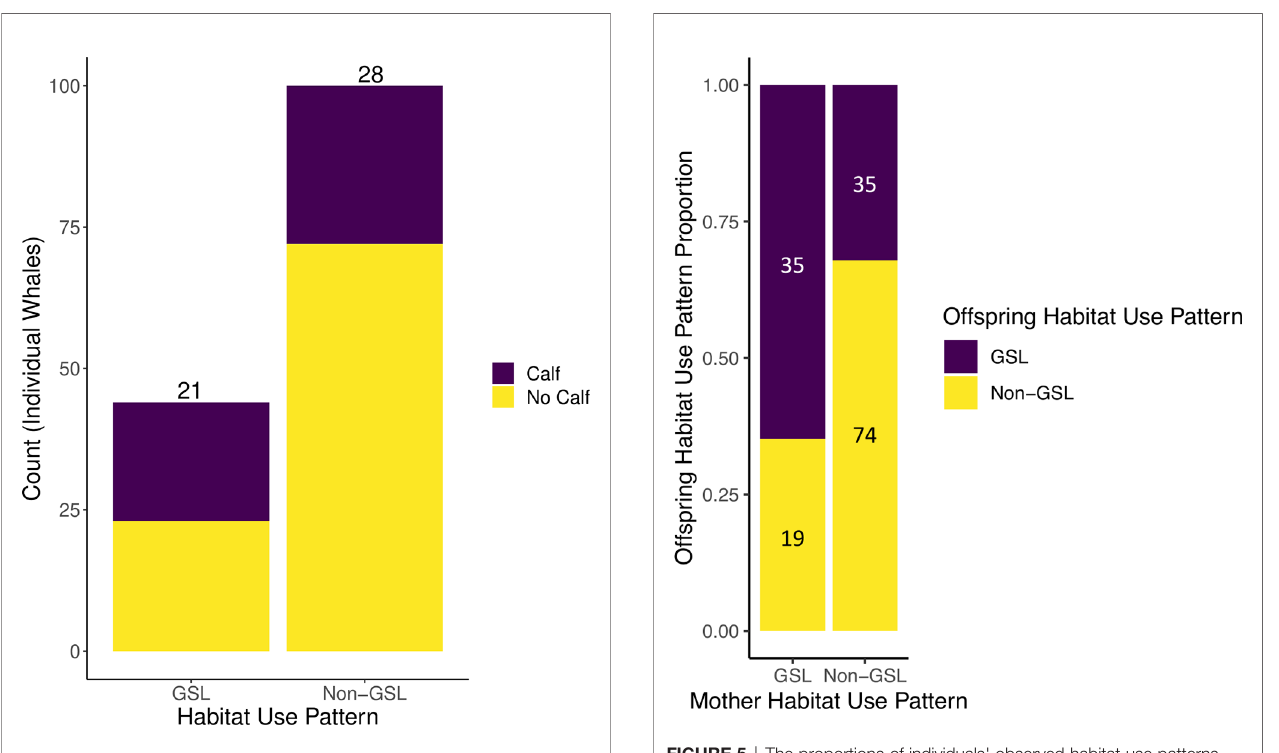
FIGURE 4 | A comparison of the number of females who were sexually mature by 2016 that did and did not have a calf between the years 2016 – 2021, parsed by habitat use. “ GSL ” indicates individuals that used the Gulf of St. Lawrence at least once during the years 2015 – 2019. “ Non-GSL ” indicates individuals that were not seen in the Gulf of St. Lawrence during the same period. The numbers at the top of the bars show the total number of mothers who gave birth in each habitat category.